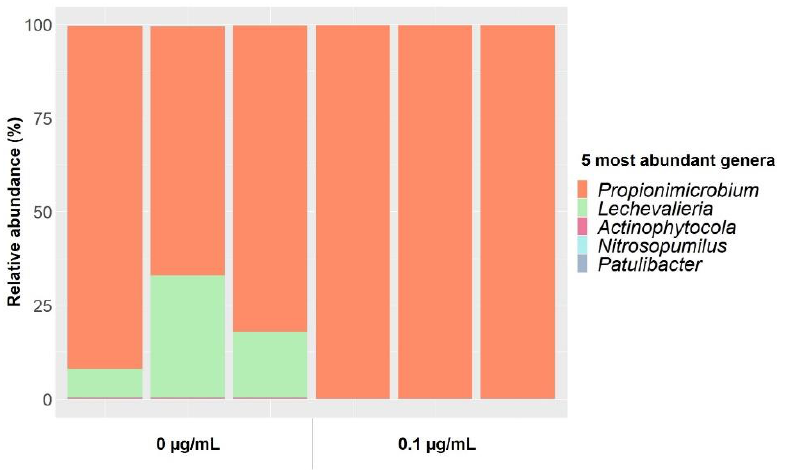
Figure 4. Relative abundances of the five most abundant genera from soil bacteria enrichments in 1:10 TSB medium incubated at 29 °C for 24 h at gentamicin concentrations of 0 and 0.1 µg/mL. Triplicates are plotted individually.